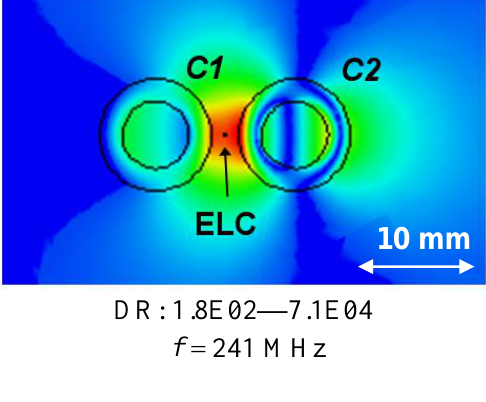
Figure 5. The magnitude of the electric field of the resonant 2-cylinder structure when the separation distance d = 5 mm for 241  f MHz, which is the frequency at which the first resonance appears in Figure 4(b). The ELC is located at )0,mm2/(),( o and the electric field is depicted in the xy -plane with the linear dynamic range (DR) in V/m indicated below the figure. Curves representing the circular surfaces of the structure and a left-right arrow, indicating the size scale of the figure, are likewise